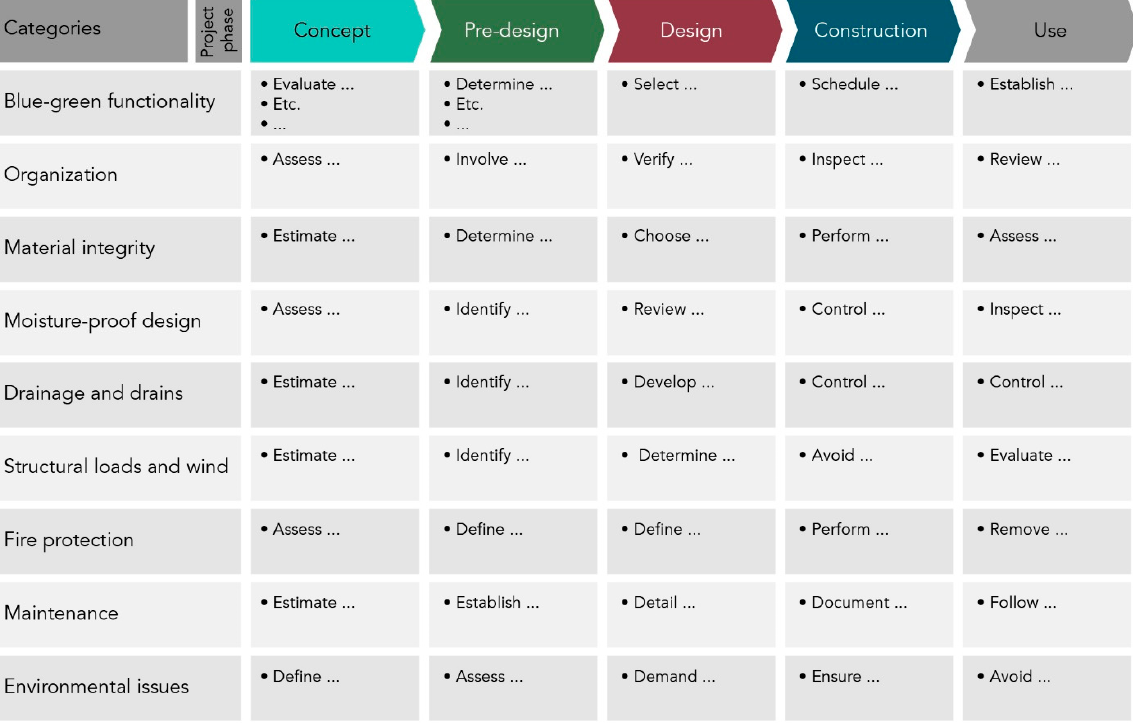
Figure 4. Principal outline of the presented quality risk reduction framework. The project phases are defined according to Figure